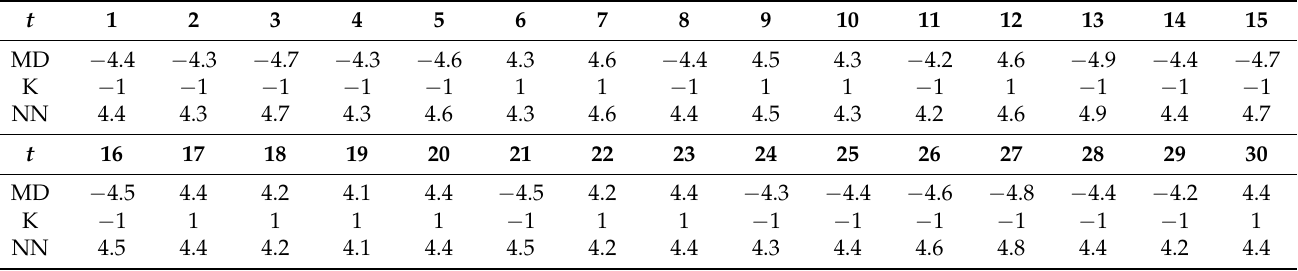
Table 8. Transformation from MD to NN state of